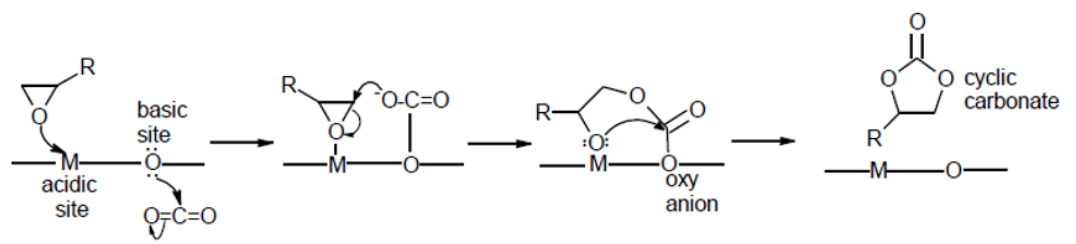
Figure 2. Proposed reaction mechanism for the cycloaddition reaction of CO 2 to ECH over an acid-base pairs. R is an alkyl group, M is a metal atom (acidic site), and O is oxygen atom (basic site).